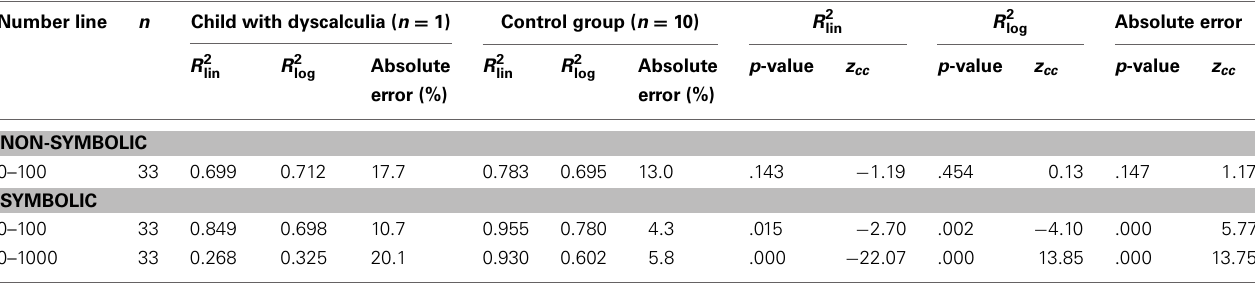
Table 2 | Summary of the results on the non-symbolic and symbolic number line tasks, number of trials, logarithmic and linear fit ( R 2 ), and percent absolute error of the child with dyscalculia and the control group including p -values and effect sizes.